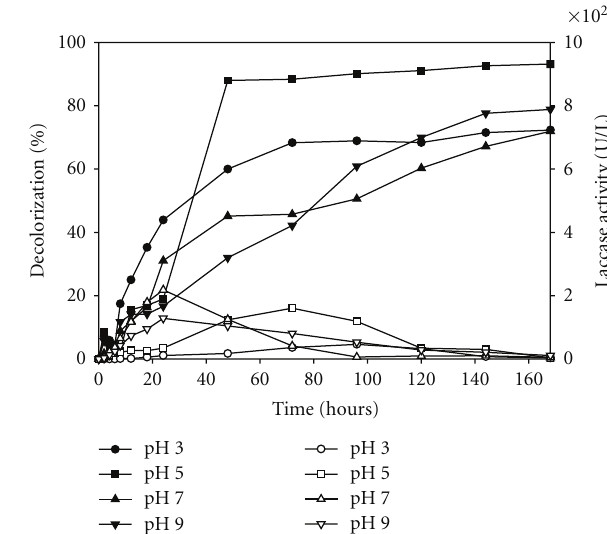
Figure 5: The e ff ect of pH on %decolorization of RBBR dye solution and Lac activity after cultivation with Datronia sp. KAPI0039; close symbol = %decolorization; open symbol = Laccase activity.